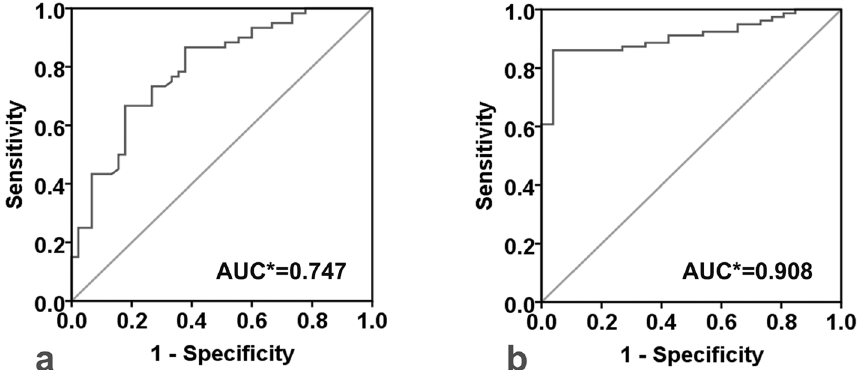
Figure 5. ( a ) Receiver operating characteristic (ROC) curve analysis for flow-mediated dilation (FMD) in predicting coronary dilation (preZmax > 2.0) during acute Kawasaki disease. ( b ) ROC curve analysis for FMD in predicting coronary aneurysm (preZmax ≥ 2.5) during acute Kawasaki disease. AUC * area under the